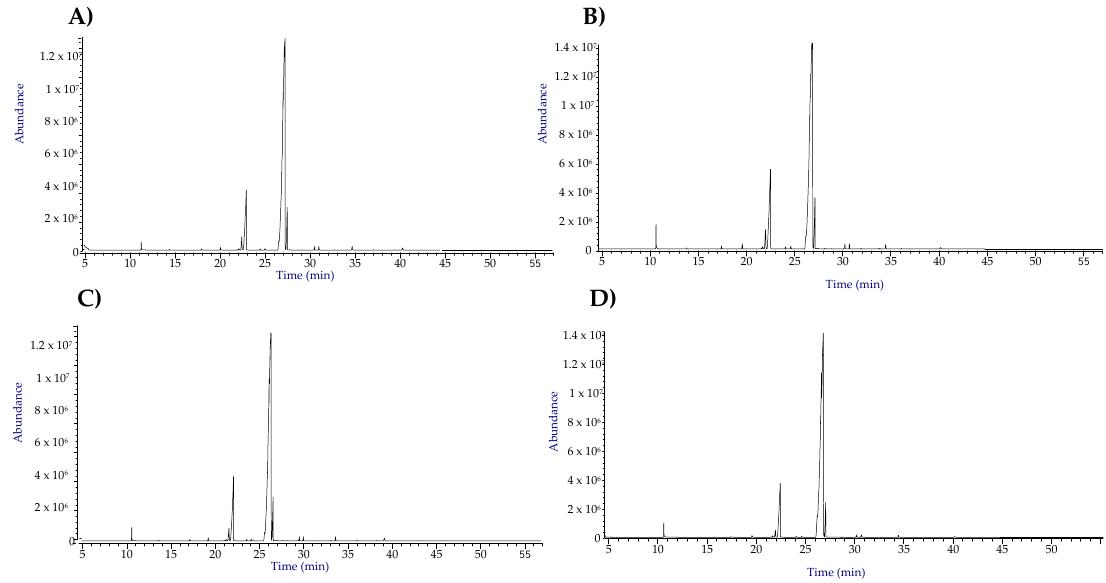
Figure 3. Total ion chromatograms (TICs) profiles of FAMEs obtained after transesterification of triglycerides contained in samples of Ganoderma lucidum extracted with different processes: ( A ) extraction with n -hexane; ( B ) extraction in Soxhlet apparatus with n -hexane; ( C ) reflux extraction with chloroform; ( D ) commercial oil .